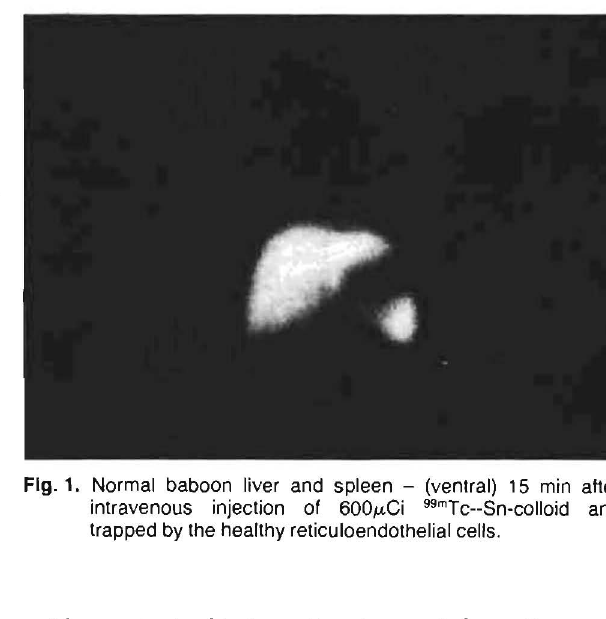
Fig. 1. Normal baboon liver and spleen - (ventral) 15 min after intravenous injection of 600/-LCi 99mTc--Sn-colloid and trapped by the healthy reticuloendothelial